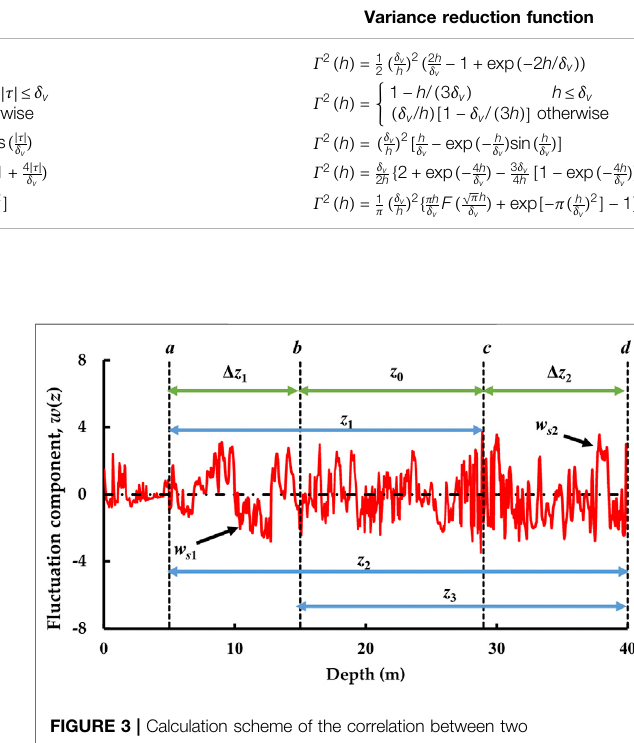
TABLE 3 | Autocorrelation models and variance reduction functions (Vanmarcke, 1977; Phoon and Kulhawy, 1999); Phoon et al., 2003; Uzielli, et al., 2005). Autocorrelation model Equation Variance reduction function